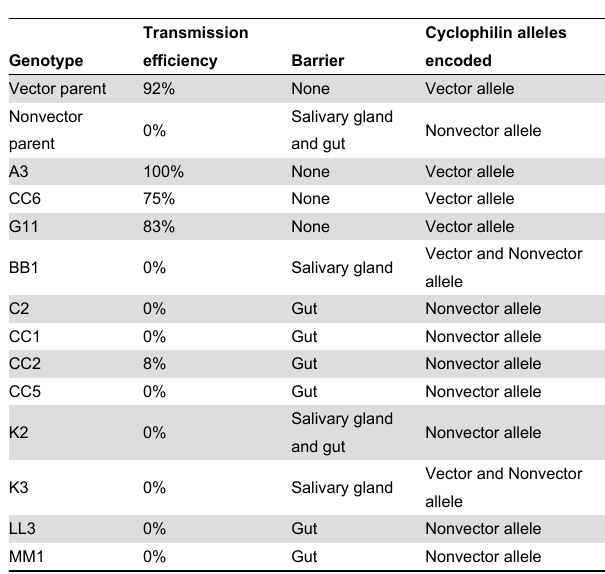
Table 2. Transmission efficiency of CYDV-RPV by analyzed F2 genotypes of S. graminum aphids and the encoded Cyclophilin alleles.